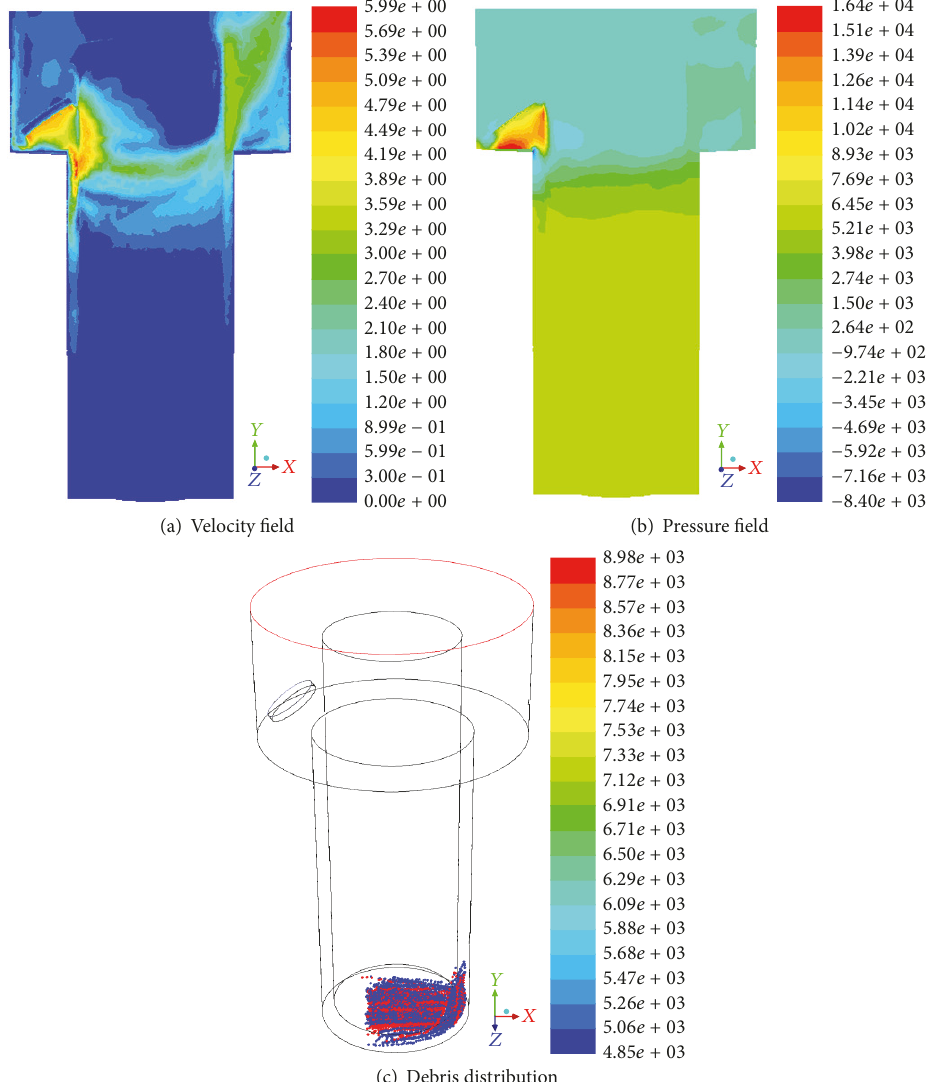
Figure 19: Schematics of gap flow field with flushing at 5 m/s and 5mm deep hole.